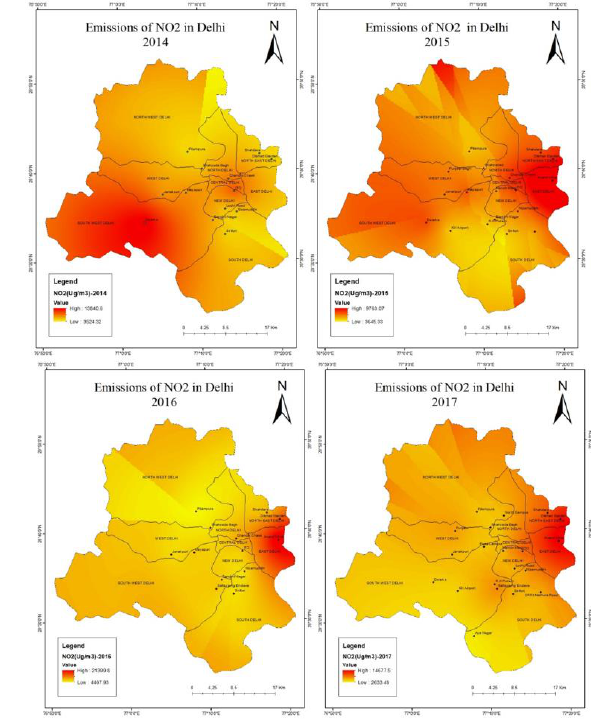
Figure 5: Trends of Nitrogen Dioxide in